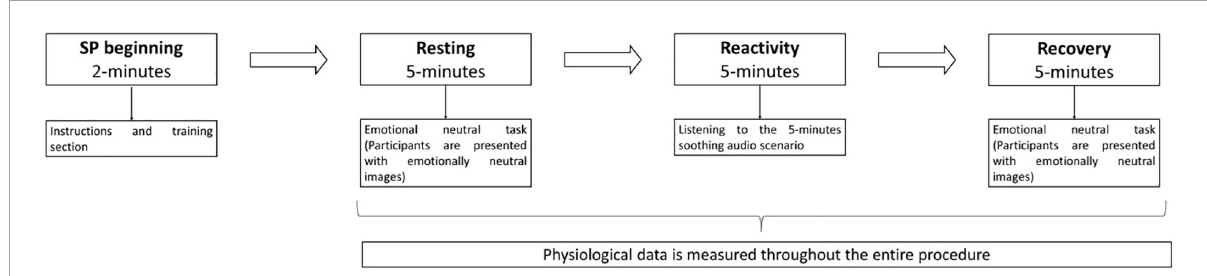
FIGURE1 Schematic presentation of the standardized procedure.